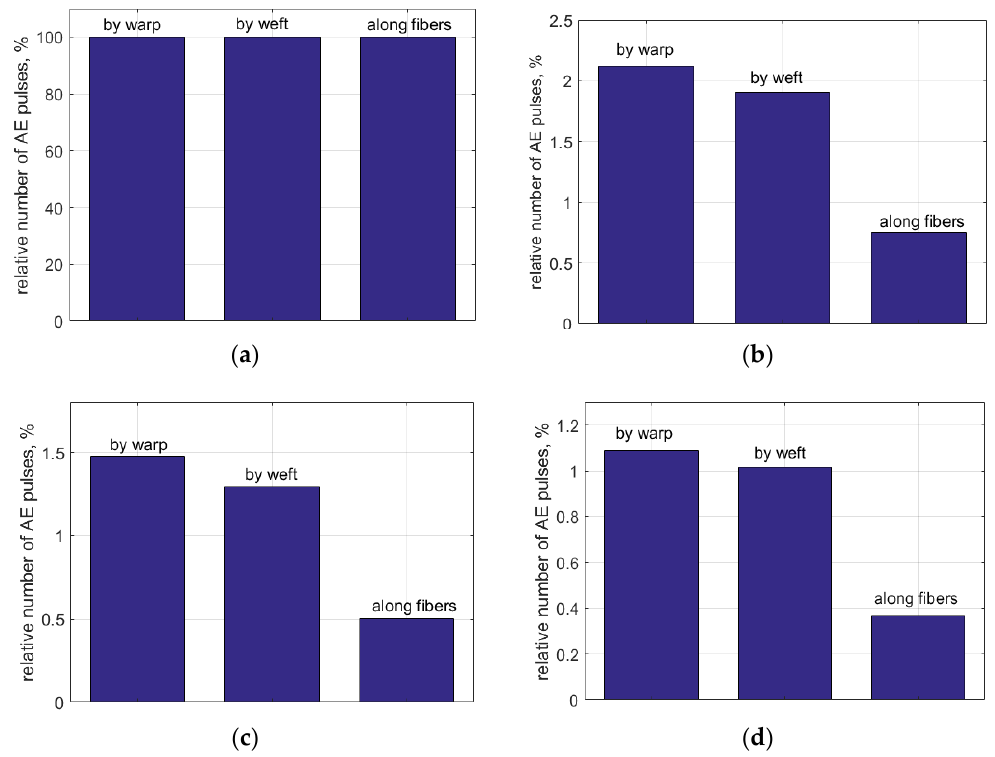
Figure 10. Relative number of detected AE pulses for each of the laboratory uniaxial tests (uniaxial tension of the woven laminate sample cut along the warp and weft directions and the unidirectional CFRP sample cut along the fiber direction) at different background noise intensity levels: 0.13 mV ( a ), 0.9 mV ( b ), 4.5 mV ( c ), 10 mV ( d )